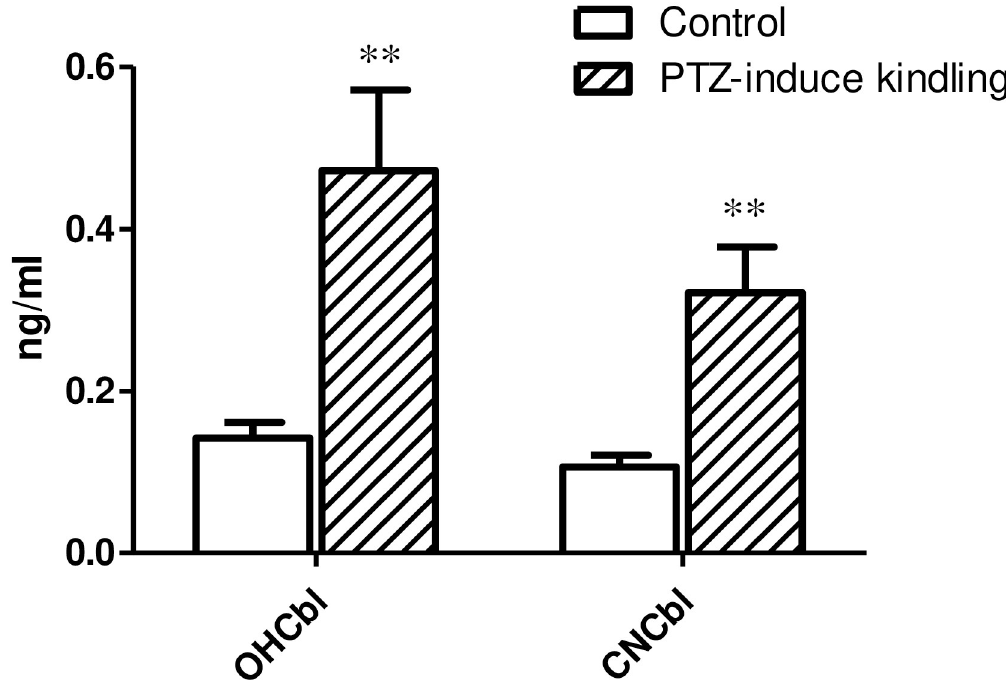
Fig 4. Histograms showing concentrations of OHCbl and CNCbl in PTZ-induced kindling rat model and controls (n = 8). Each bar represents the mean value; variability is shown by standard error of mean (SEM). Asterisks represent significant